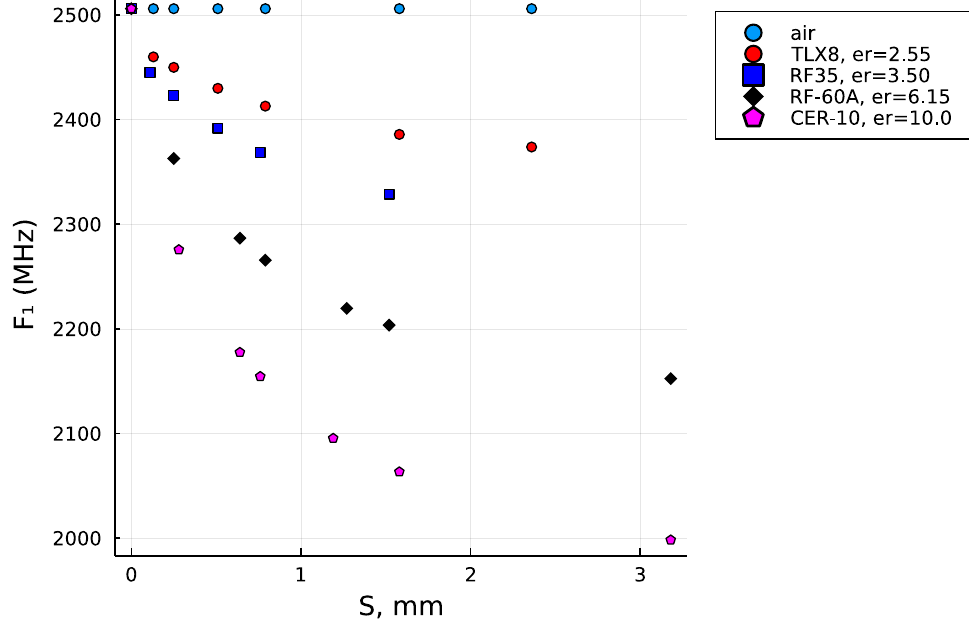
Figure 2. The resonant frequency values evaluated using a full-wave solver for the thickness- and permittivity values of the four known laminates. Table 1. The reference data